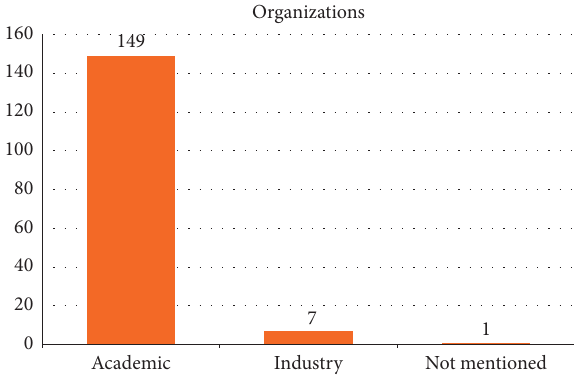
Figure 18: Affiliation of organizations (academic/industry). Table 8: Most active publication